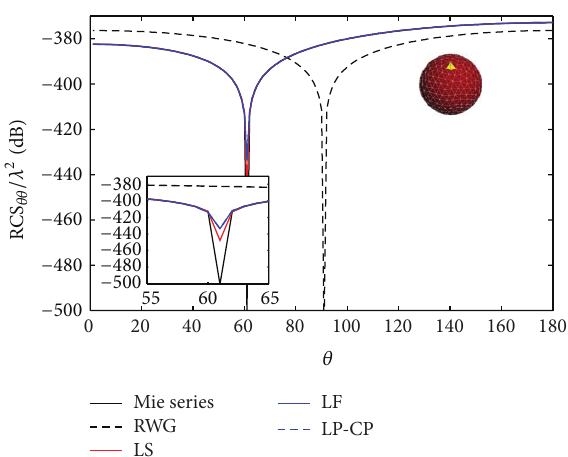
Figure 5: BiRCS ( 𝜙 = 0 ∘ ) of the PEC sphere @ 0.01 Hz.